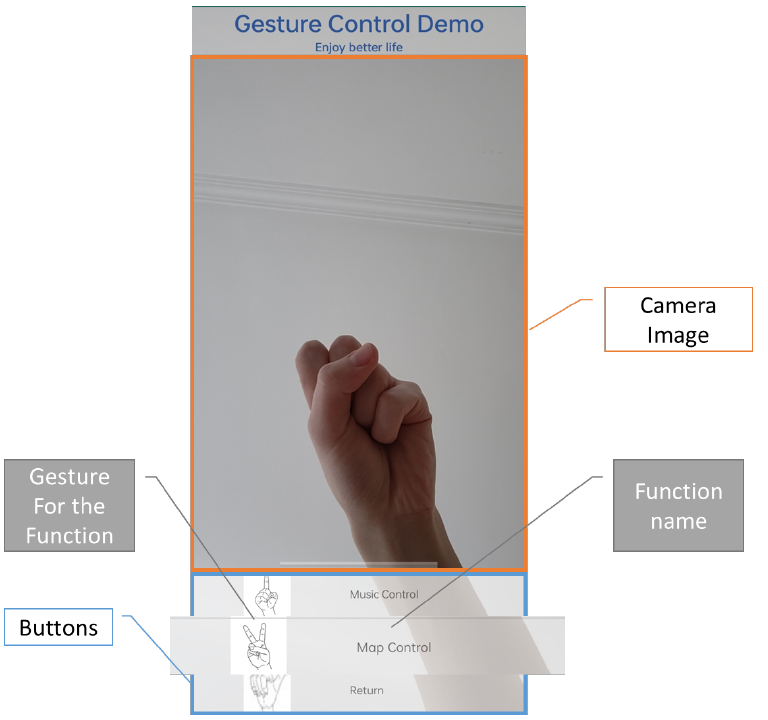
Figure 6. Main menu. The location of the Camera Image and Buttons is shown in the picture. Each button adds a gesture photo and function name.